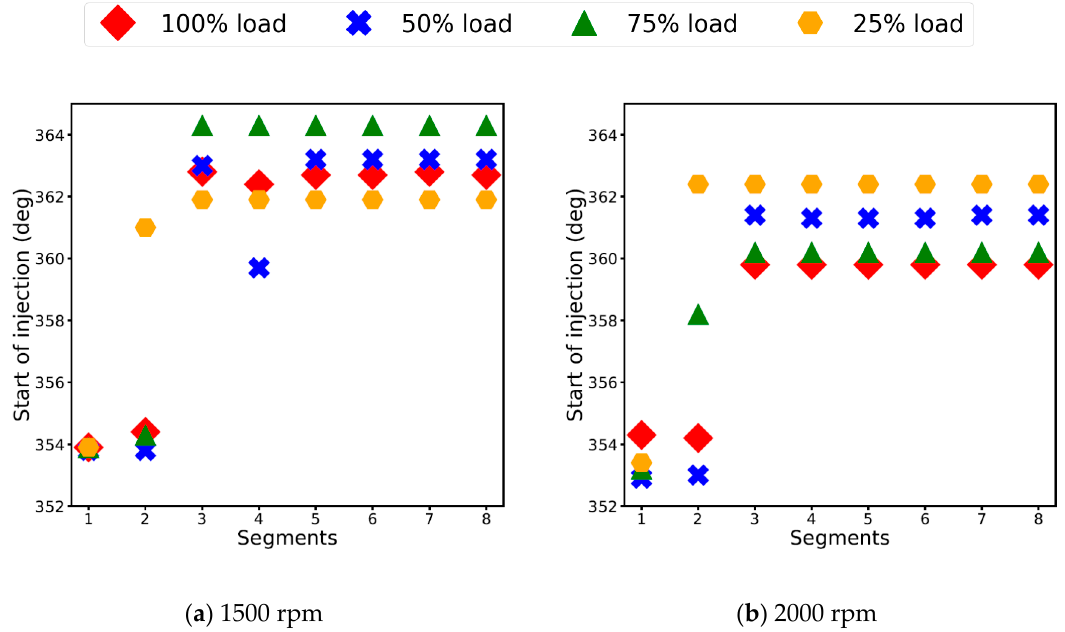
Figure 9. Start of injection at all loads in each stage at ( a ) 1500 rpm and ( b ) 2000 rpm. The red thick diamond represents 100% load, the blue thick cross 50% load, the green triangle 75% load and the orange hexagon 25% load (Figure adapted from [20]).